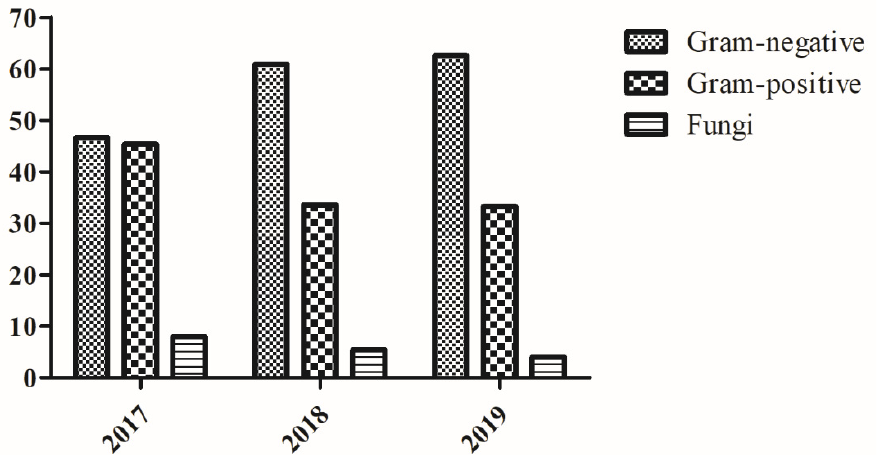
Figure 2. Percentage distribution of groups of microorganisms stratified by year. Stratifying the data by source of the samples (community or hospital), the rise linear trend for Gram-negative bacteria, in the study period, remains statistically significant both for the samples coming from the hospital ( p = 0.031) and for those coming from the com- munity ( p = 0.027). 3. Discussion Routine testing in microbiology laboratories has largely based on culture methods that allow to detect and isolate potential pathogens from swabs, pus or tissue biopsies in